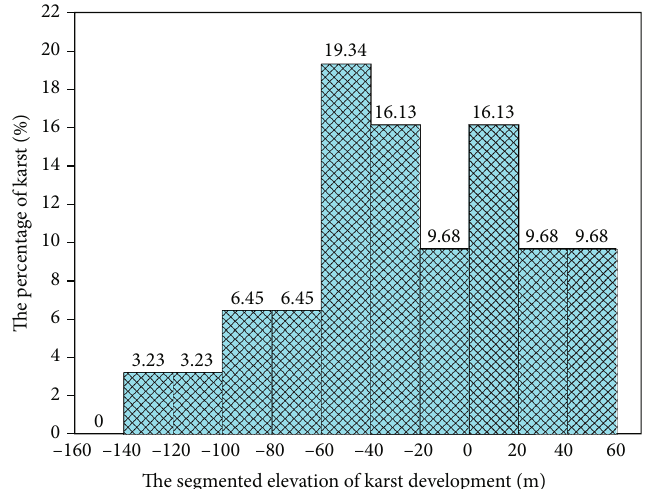
Figure 4: The statistical results of karst revealed by drilling.